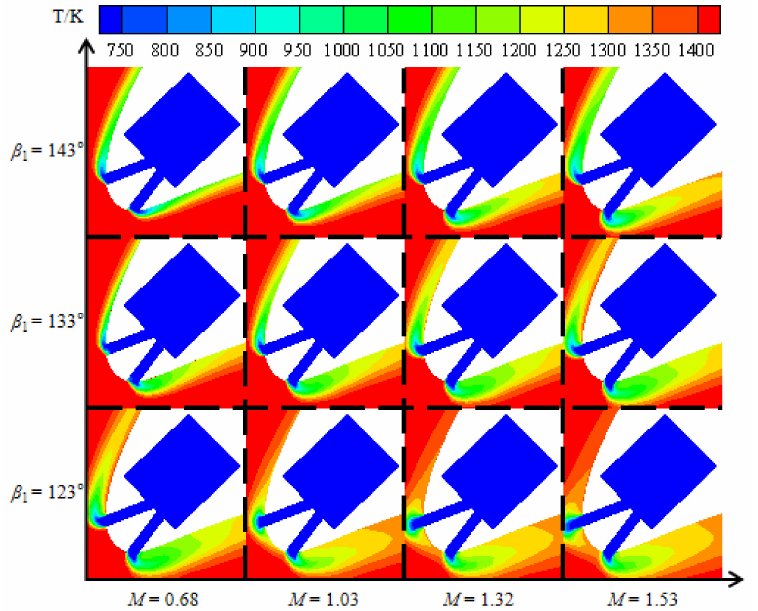
Figure 4. Temperature contours on the middle sections of the blade leading